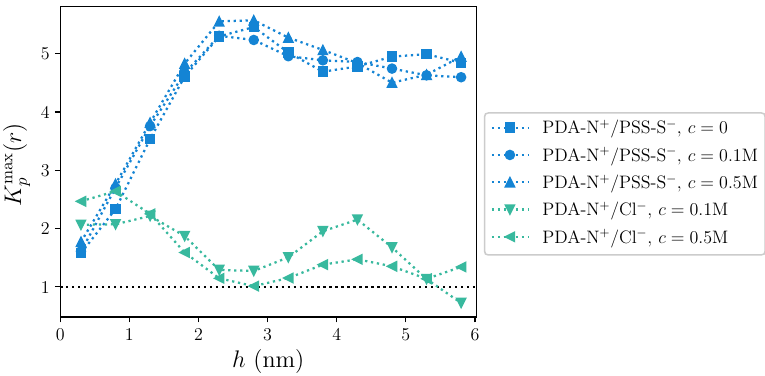
Figure 6. Values of the maxima of the local/bulk partition coefficient, K max p ( r ) , as a function of the distance to the substrate, h , for PDA-N + /PSS-S − and PDA-N + /Cl − charge pairings. Horizontal dashed line indicates the limit between preferential accumulation/exclusion